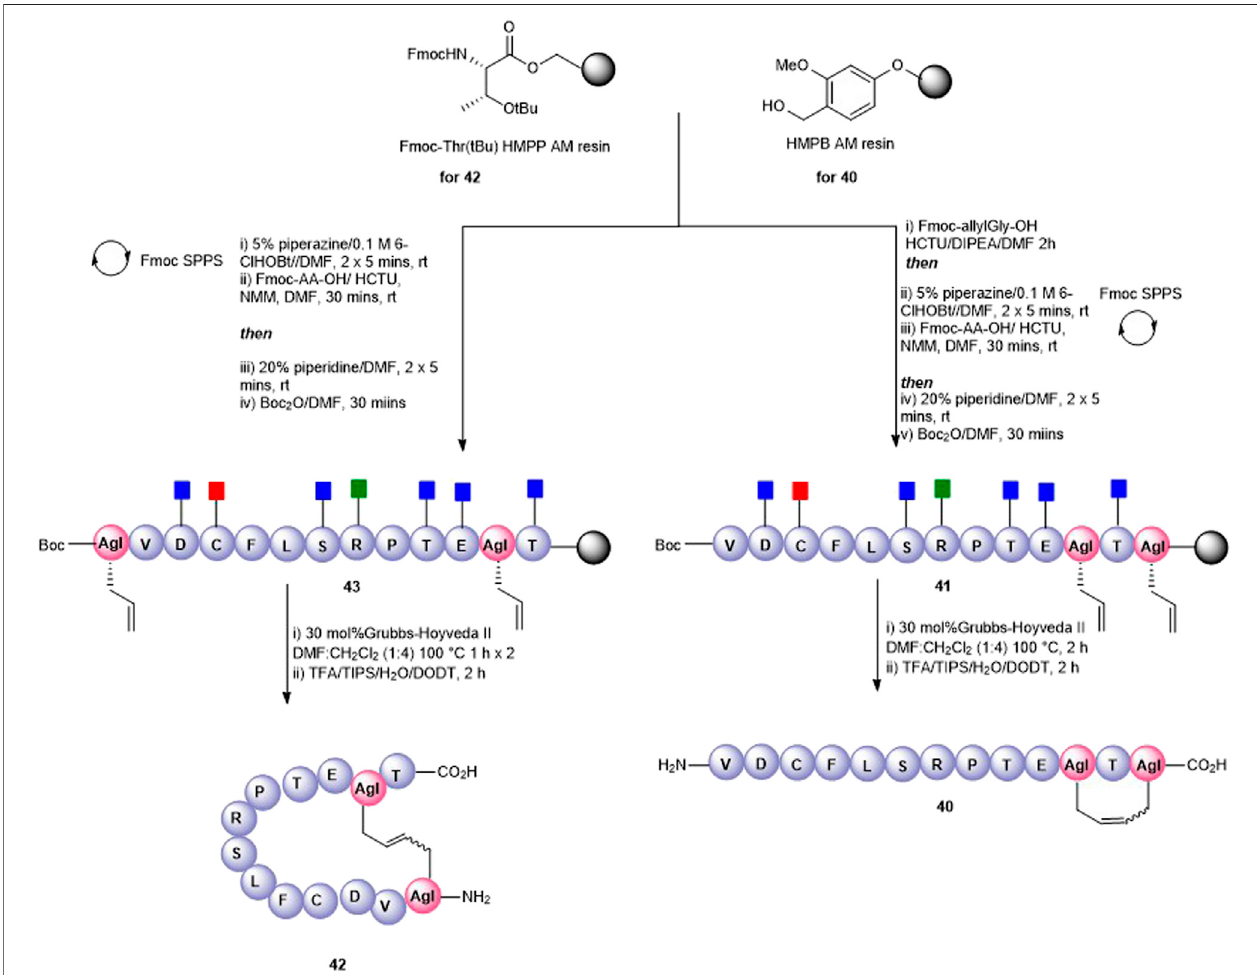
FIGURE 10 | Synthesis of an all-carba head-to-side-chain macrocycle 42 and a tail-to-side-chain variant 40 by ring-closing metathesis.